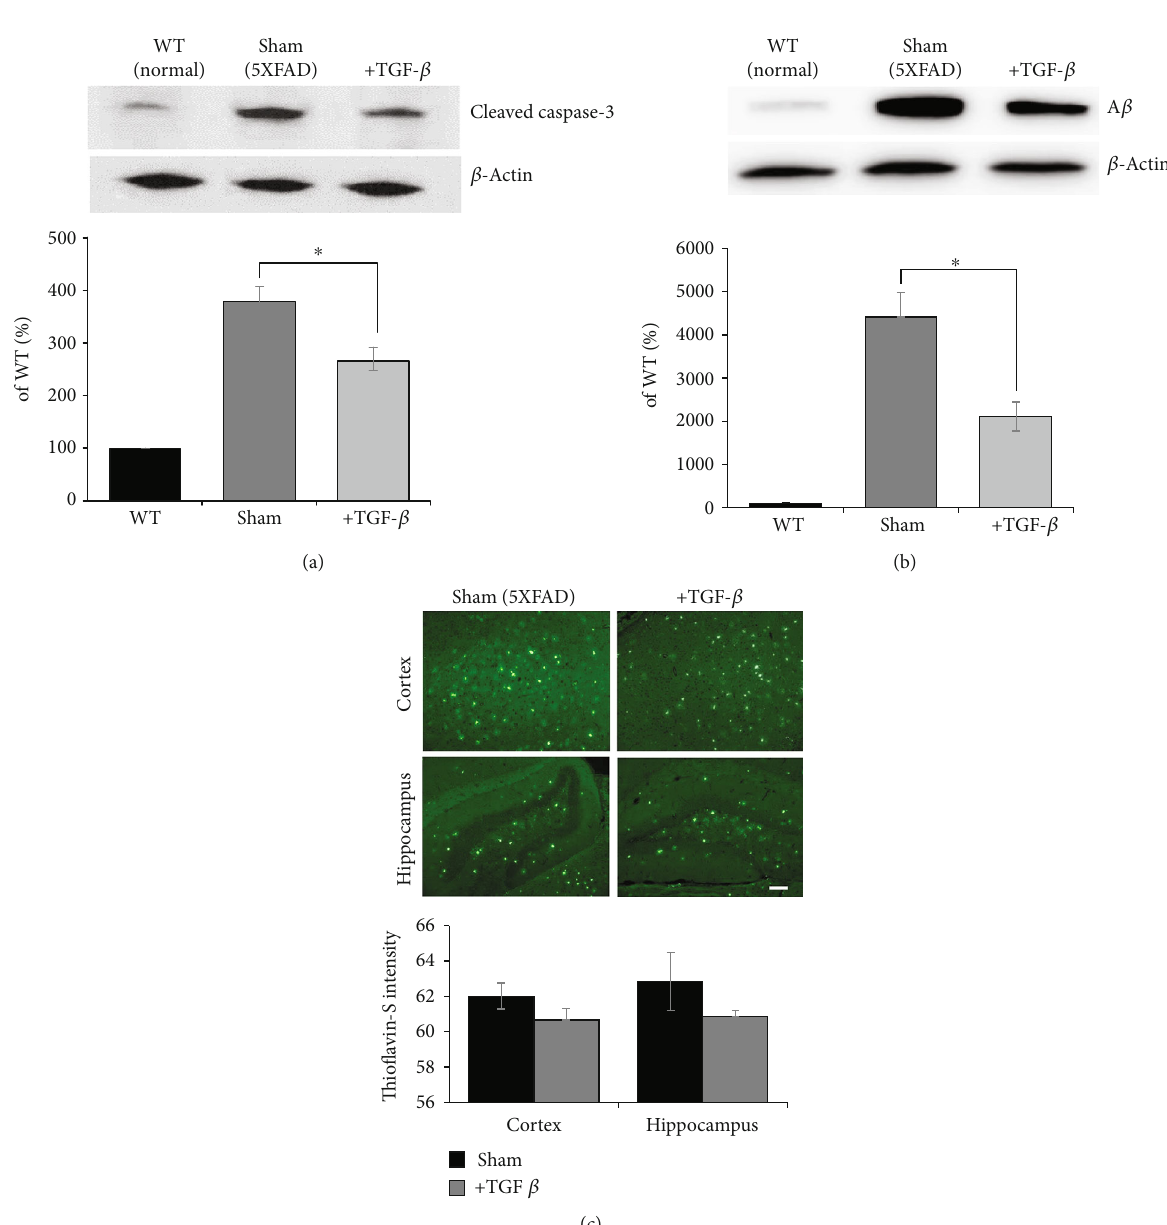
Figure 6: Therapeutic e ffi cacy of TGF- β in 5xFAD mice. (a) Changes in cleaved caspase-3 were measured in the experimental groups: WT, sham, and TGF- β . (b) Secreted amyloid-beta levels in the brain were measured. (c) Thio fl avin-S staining was performed, and fl uorescent images from the cortex and hippocampus of each group are shown. Scale bar: 100 μ m. The data are presented as the mean ± S : E : M . ∗ p < 0 : 05